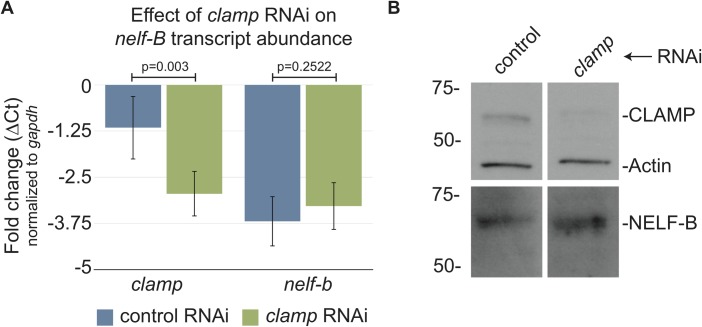
CLAMP does not regulate NELF-B protein abundance.(A) Transcript abundance for clamp and nelf-b was measured to determine the difference in transcript abundance between control (gfp, blue) and clamp (green) RNAi treatment by qPCR. The average fold change (ΔCt compared to gapdh) from four biological replicates is shown for both clamp and nelf-b transcripts. As expected, abundance of clamp is reduced after clamp RNAi, while nelf-b transcript abundance is not affected compared to the control RNAi. The error bars represent +/- 1 S.D., with p-values indicated. (B) Protein accumulation was measured by western blot for both CLAMP and NELF-B after of clamp and gfp control RNAi. RNAi targeting clamp reduces the amount of CLAMP protein but has no effect on NELF-B protein levels. Actin is used as a loading control.